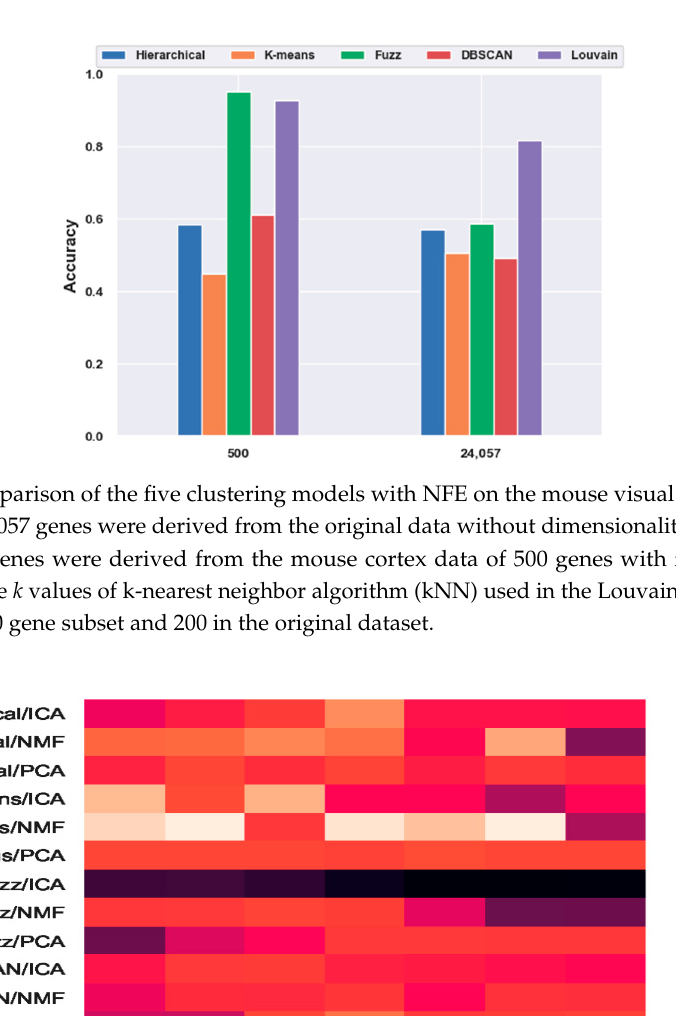
Figure 11. Comparison of the five clustering models with NFE on the mouse visual cortex data. The results from 24,057 genes were derived from the original data without dimensionality reduction. The results of 500 genes were derived from the mouse cortex data of 500 genes with feature selection. Additionally, the k values of k-nearest neighbor algorithm (kNN) used in the Louvain models were set to 500 in the 500 gene subset and 200 in the original dataset.